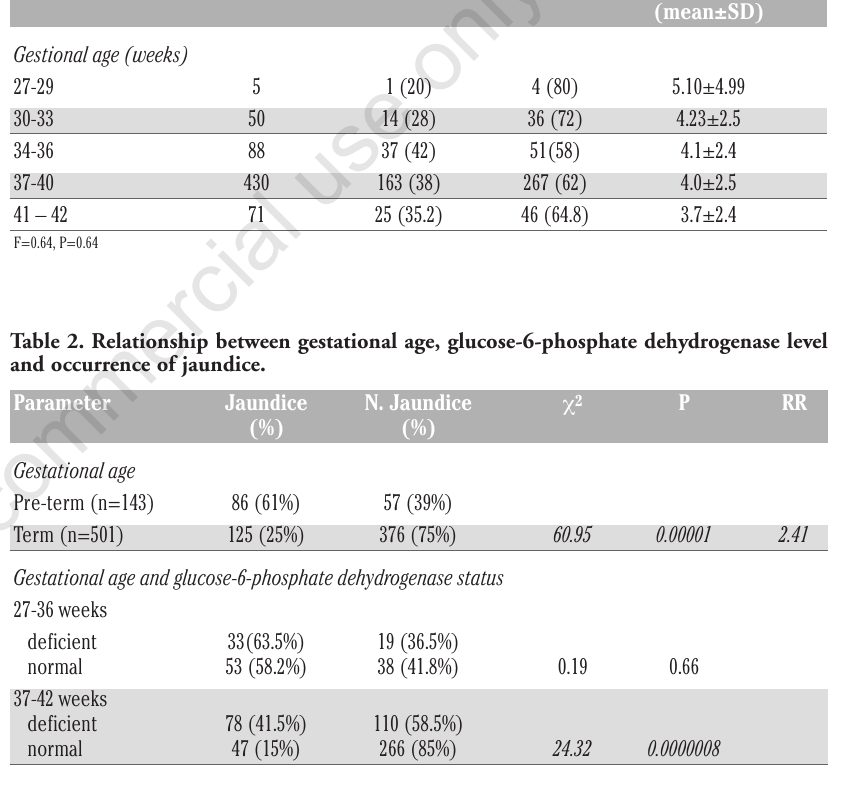
Table 1. Mean Glucose-6-phosphate dehydrogenase levels in relation to gestational age in the total population studied. Variable